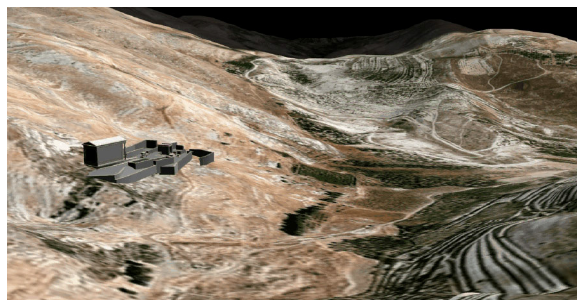
Figure 12. The Terrain model with the integration of the Hosn-